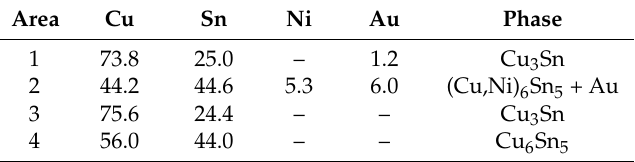
Figure 6. Cross-sectional SEM images of the interfaces between the bonding layer and ( a ) chip and ( b ) substrate, as-bonded. Table 1. Chemical composition (at.%) in the marked areas in Figure 6 measured by EDX spectroscopy.